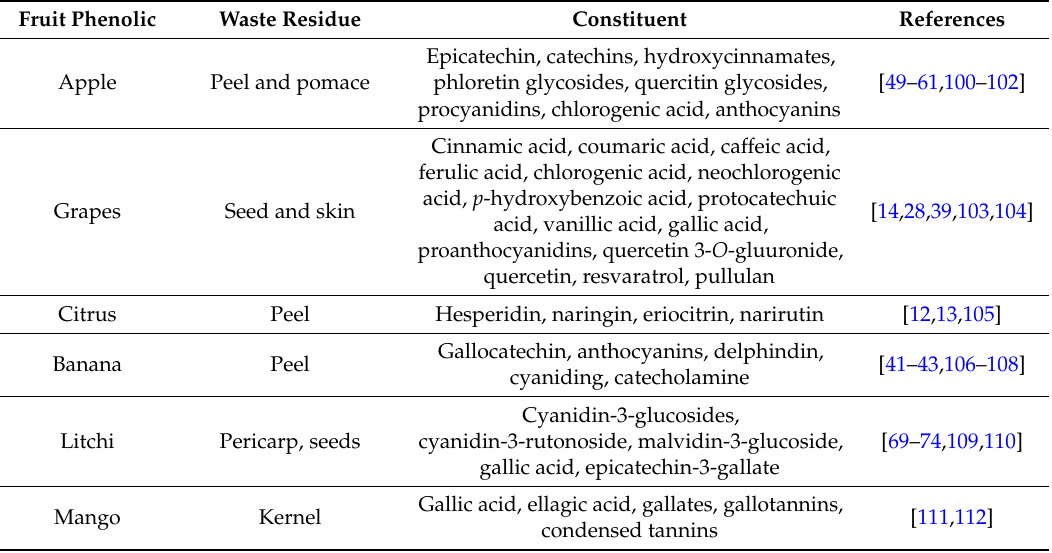
Table 1. Phenolic constituents as nutraceuticals from different fruit